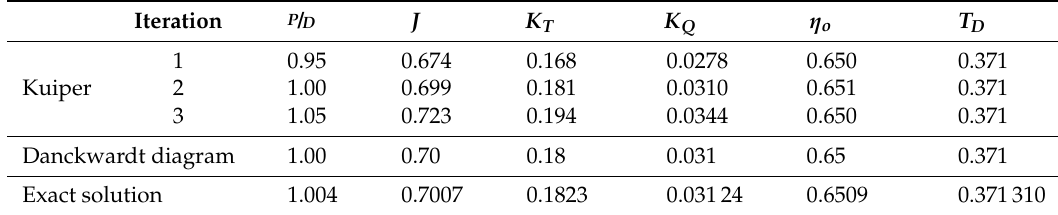
Table A3. The solutions for “Example 1” in Kuiper’s book [15], as obtained by Kuiper using the program supplied with the book by using Danckwardt diagrams and the exact